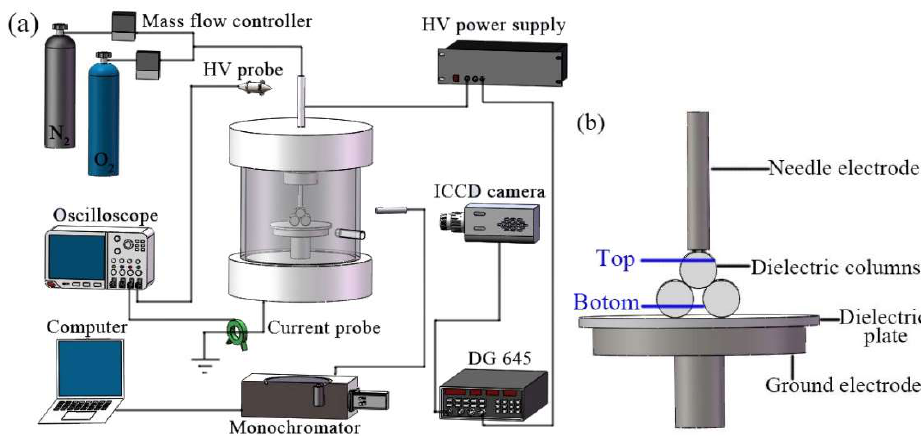
Figure 1. ( a ) The experiment setup and ( b ) magnified view of the electrode